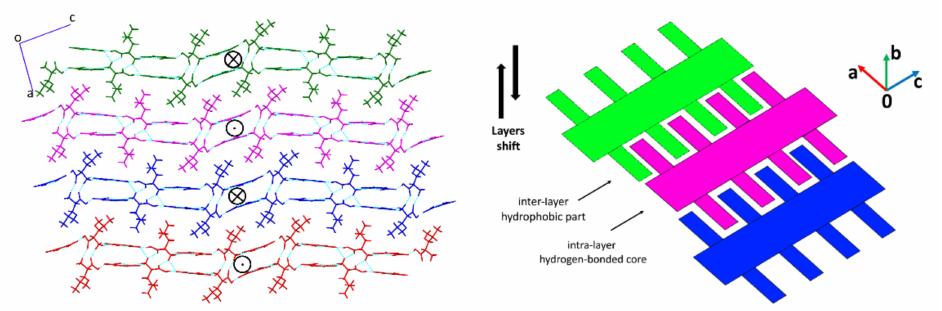
Figure 1. Crystallographic ( left ) and schematic ( right ) representation of the layered structure of LLHM, showing layers that shift resulting in plasticity under mechanical stress (adapted from [34,35]). Layers’ shifts are marked with an arrow sign depending on the direction of